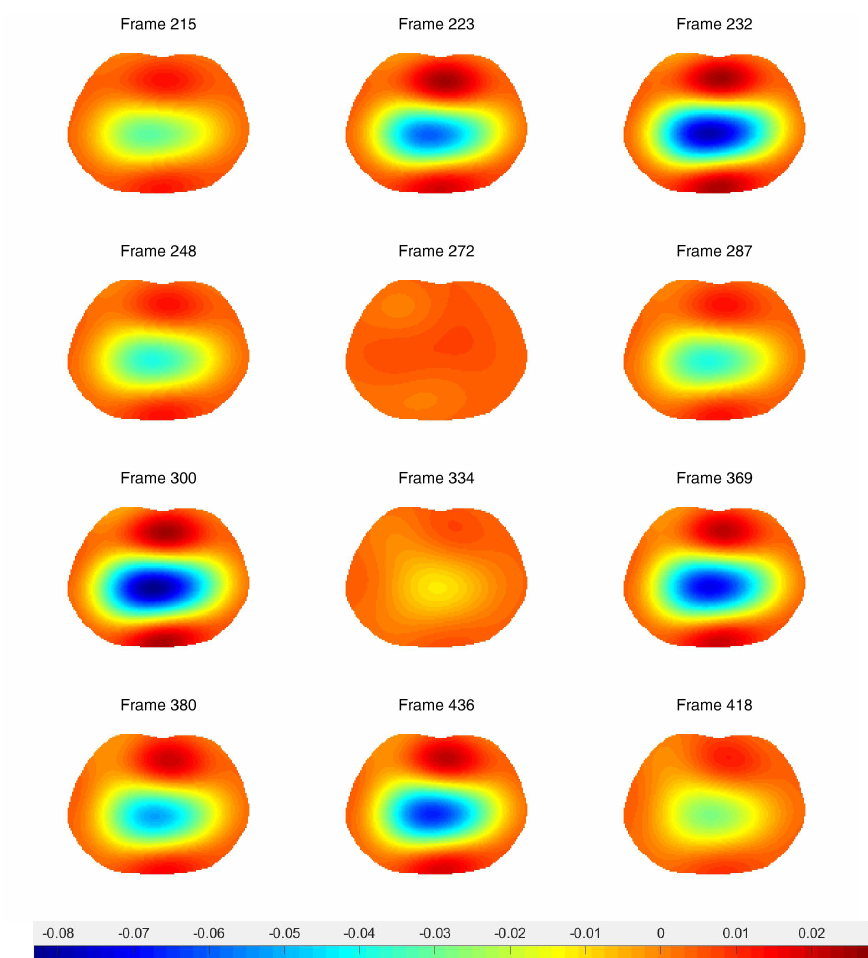
Figure 8. Difference images of ventilation data with no spatial prior included in the algorithm. Frame 200 is used for the reference image. The truncation radius is